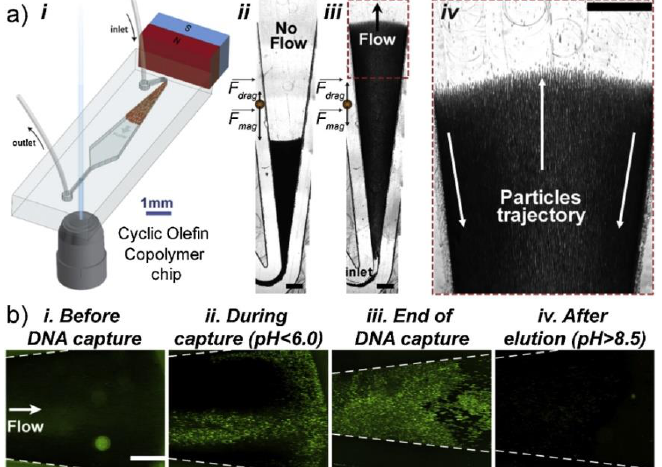
Figure 2. Schematic of the microfluidic Magnetic ExTRactiOn procedure (METRO) using the fluidized bed ( a-i ). Micrographs of the fluidized bed before ( a-ii ) and during (cfDNA) sample added to chip. ( a-iv ) showing the recirculation of beads. Fluorescence micrographs showing DNA-beads interaction inside the fluidized bed, before ( b-i ), during ( b-ii ), at the end of DNA capture step ( b-iii ), and after DNA elution ( b-iv ). Scale bars: 500 μm . Reproduced with permission from [39].